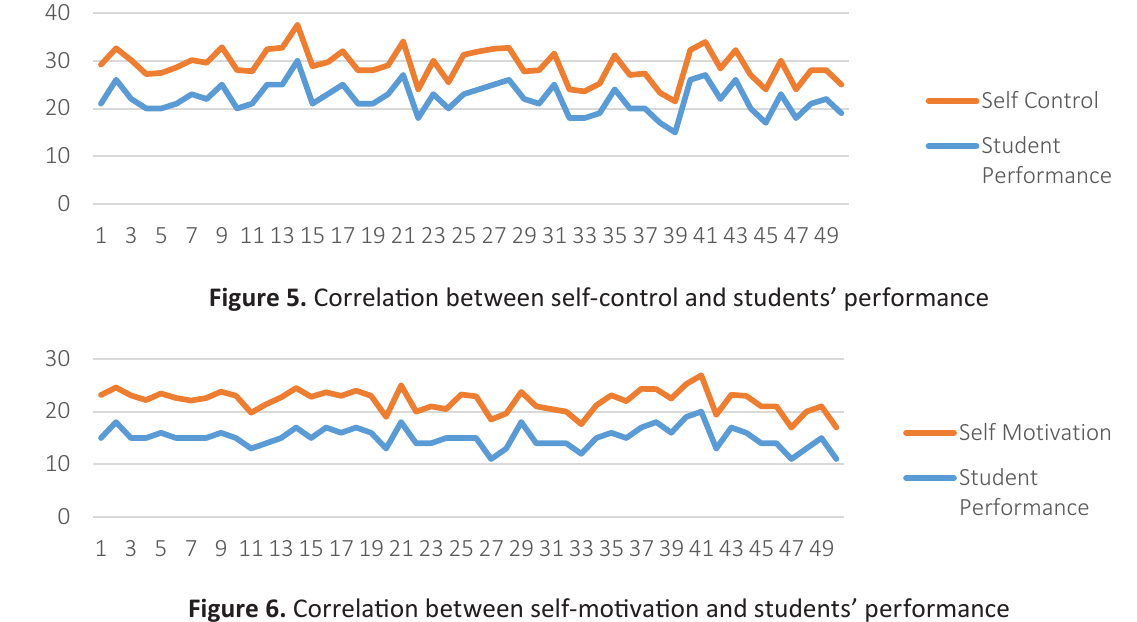
Figure 6. Correlation between self-motivation and students’ performance